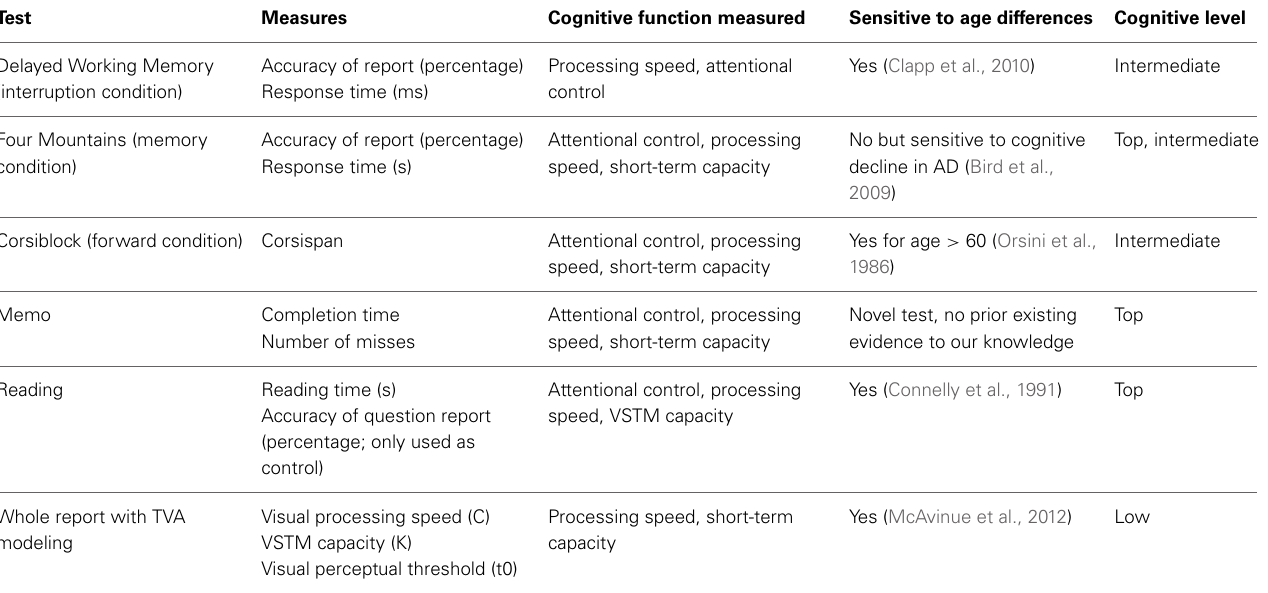
Table 1 | Overview of the